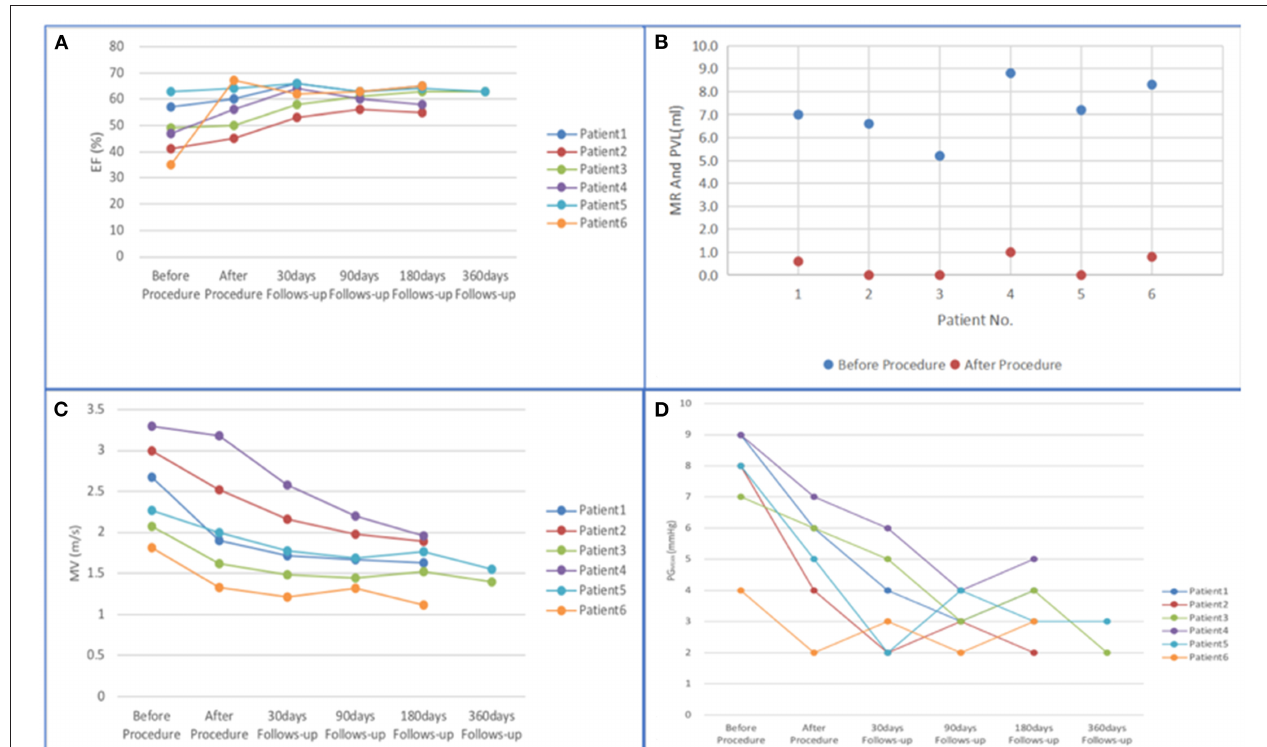
FIGURE 6 | (A–D) Changes in mitral valve function from baseline to 360 days. (EF, ejection fraction; PVL, paravalvular leak; MR, mitral regurgitation; MV, maximal diastolic velocity through mitral valve; PG MEAN , mean diastolic gradient through mitral valve).